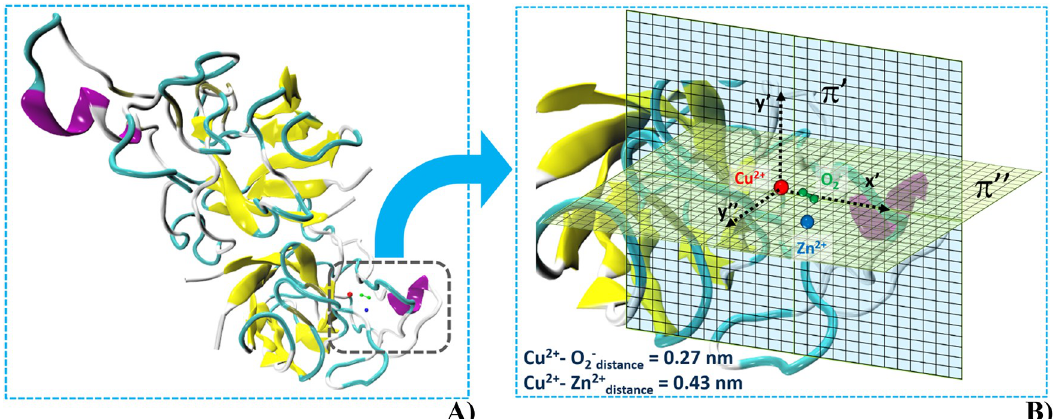
Fig 2. SOD,Cu-Zn dimer and active site (2D) grid for the local E field distribution calculation. (A) Molecular model of the SOD1 dimer, represented via VMD software [54]. ( B) Two orthogonal grids with a 4.7 x 4.7 nm 2 surface are reported. The π “grid represents a plane passing through the atomic coordinates of Cu 2+ , O 2- , Zn 2+ with the x’-axis oriented on (Cu 2+ - O 2- ) direction and y”-axis normal to it. The plane π ‘ is orthogonal to π “with the x’-axis oriented on (Cu 2+ - O 2- ) direction and y’-axis orthogonal to both x’ and y”, respectively. Some relevant residues within the active site are depicted in the figure, in particular the GLU133, GLU132, ASN131 reported as a purple α -helix and white coil for the glutamatic acid and the aspargine,